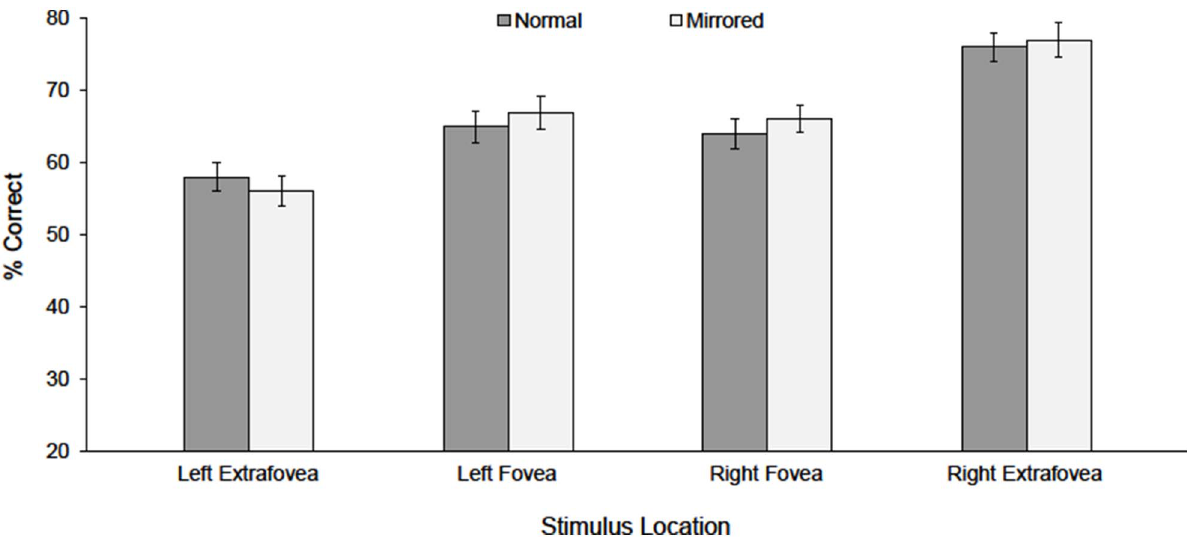
Figure 2. Mean percentages (% Correct) and standard errors for stimuli correctly identified in each location.